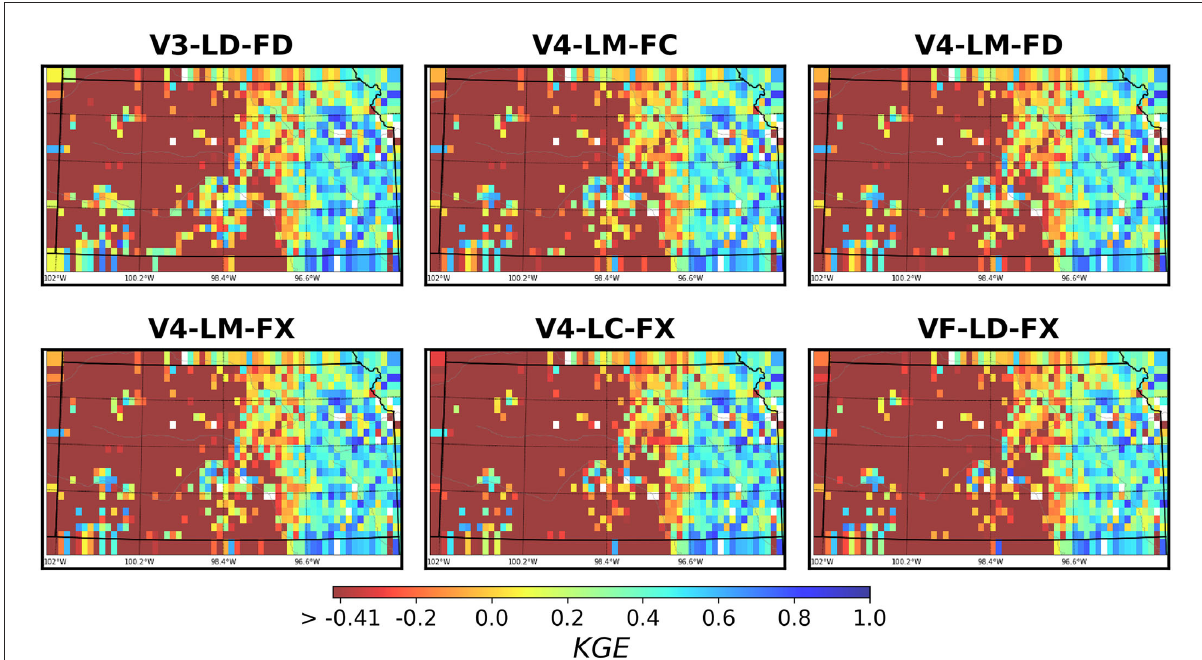
FIGURE7 Spatial distribution of seasonally averaged Kling-Gupta efficiency (KGE) of LE flux (W m – 2 ) between each Noah-MP configuration and MODIS. For the three assessment criteria, a value of 1 indicates a perfect agreement between MODIS and the simulations. The minimum threshold is set to 0.41 for any KGE values − ≤ −